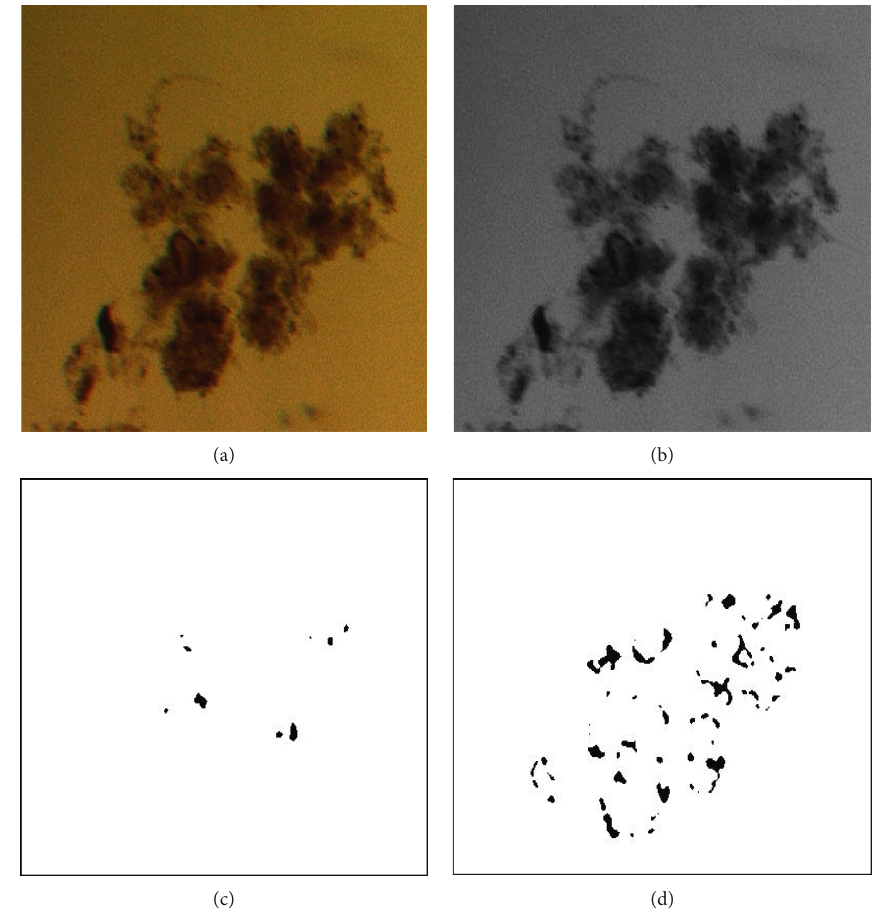
Figure 5: Image 2 segmentation results: (a) original image, (b) grayscale image, (c) segmentation results using Canny, and (d) segmentation results using our